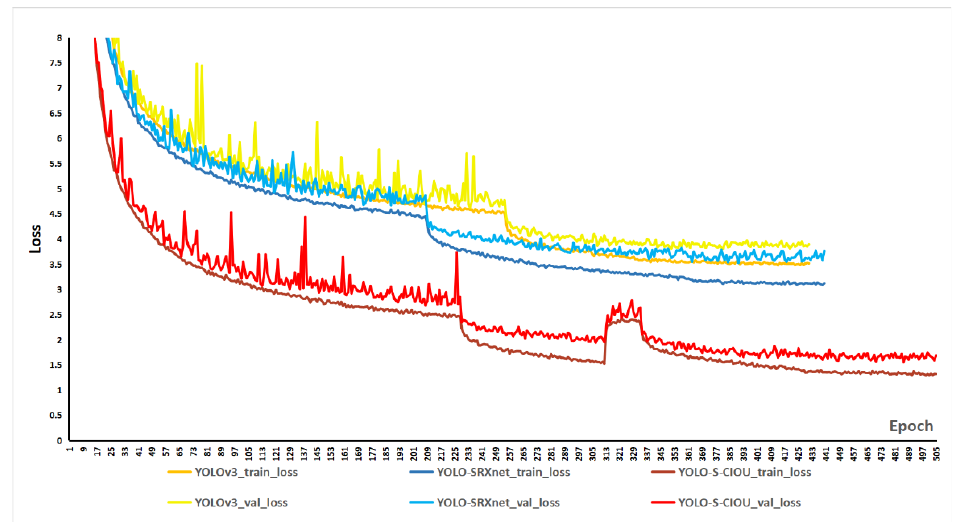
Figure 9. Loss curves of three networks. The two red-tone curves are the training and validation loss curves of YOLO- S-CIOU; the two blue-tone curves are the training and validation loss curves of YOLO-SRXnet; and the two yellow-tone curves are the training and validation loss curve of YOLOv3. The more vivid one in the two curves of the same network is the validation loss curve.